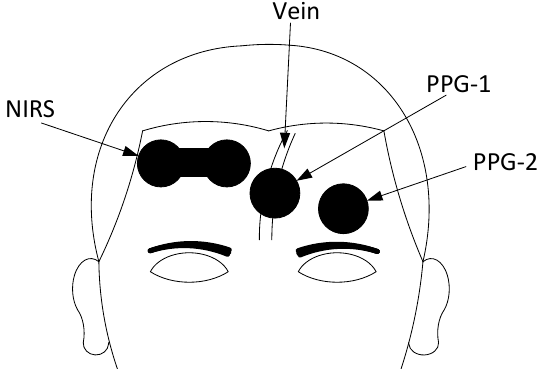
Figure 2. Positioning of the PPG and NIRS sensors on the forehead. One PPG sensor (PPG-1) was placed on top of the supratrochlear vein, while a second sensor (PPG-2) was placed on a vein-free area just above the eyebrow. The NIRS sensor was attached opposite with respect to the PPG-2